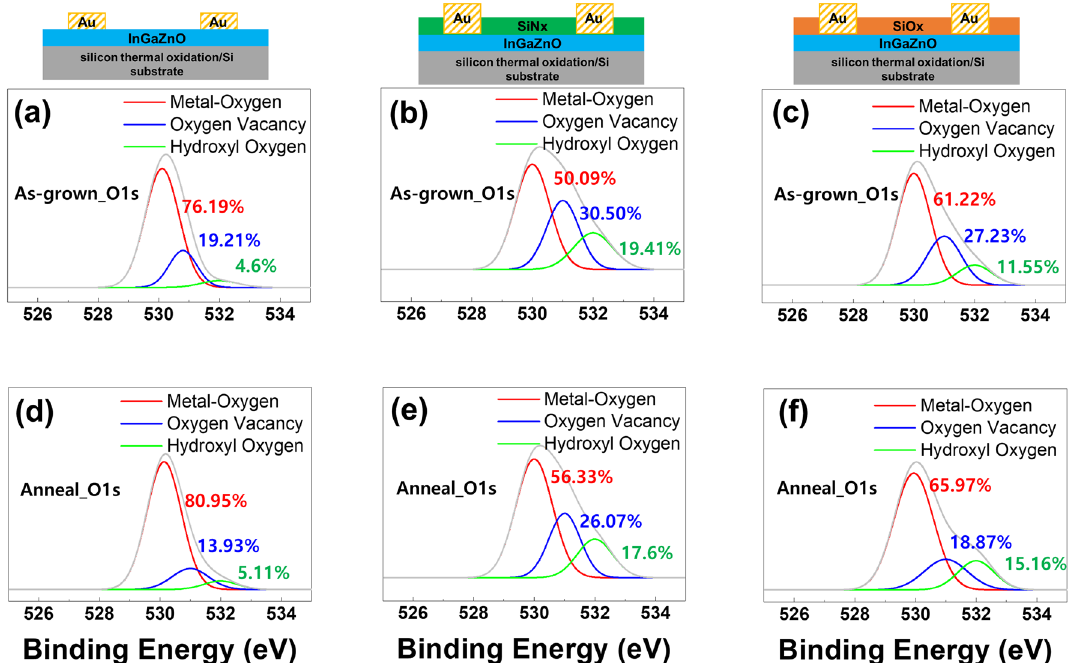
Figure 4. XPS deconvolutions of O1s intensities in a -IGZO films; ( a ) as-grown a -IGZO film, ( b ) as-grown conventional a -IGZO film covered with SiN x , ( c ) as-grown a -IGZO film covered with SiO x , ( d ) annealed conventional a -IGZO film, ( e ) annealed a -IGZO film covered with SiN x , and ( f ) annealed a -IGZO film covered with SiO x